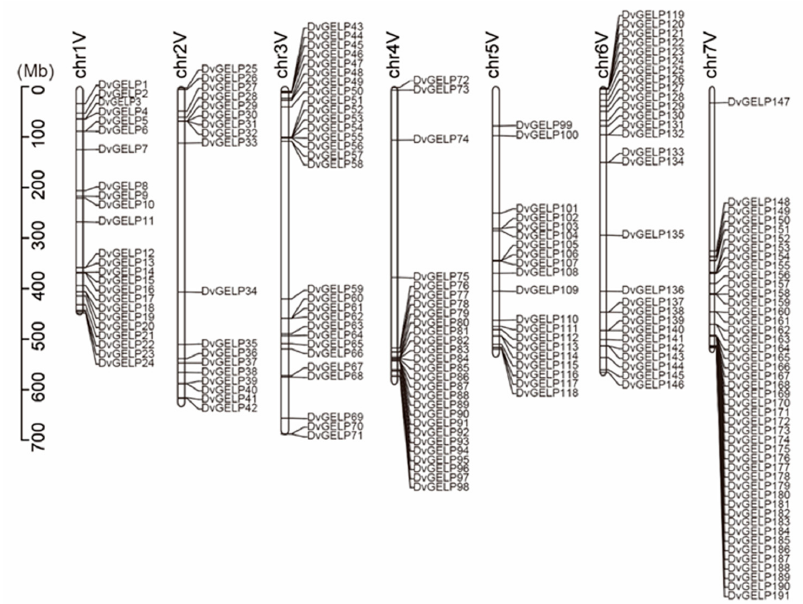
Figure 2. Chromosomal location of DvGELPs in D. villosum . The identities of the chromosome are indicated at the top of each chromosome, while the GELP gene names are shown to the right of each chromosome.